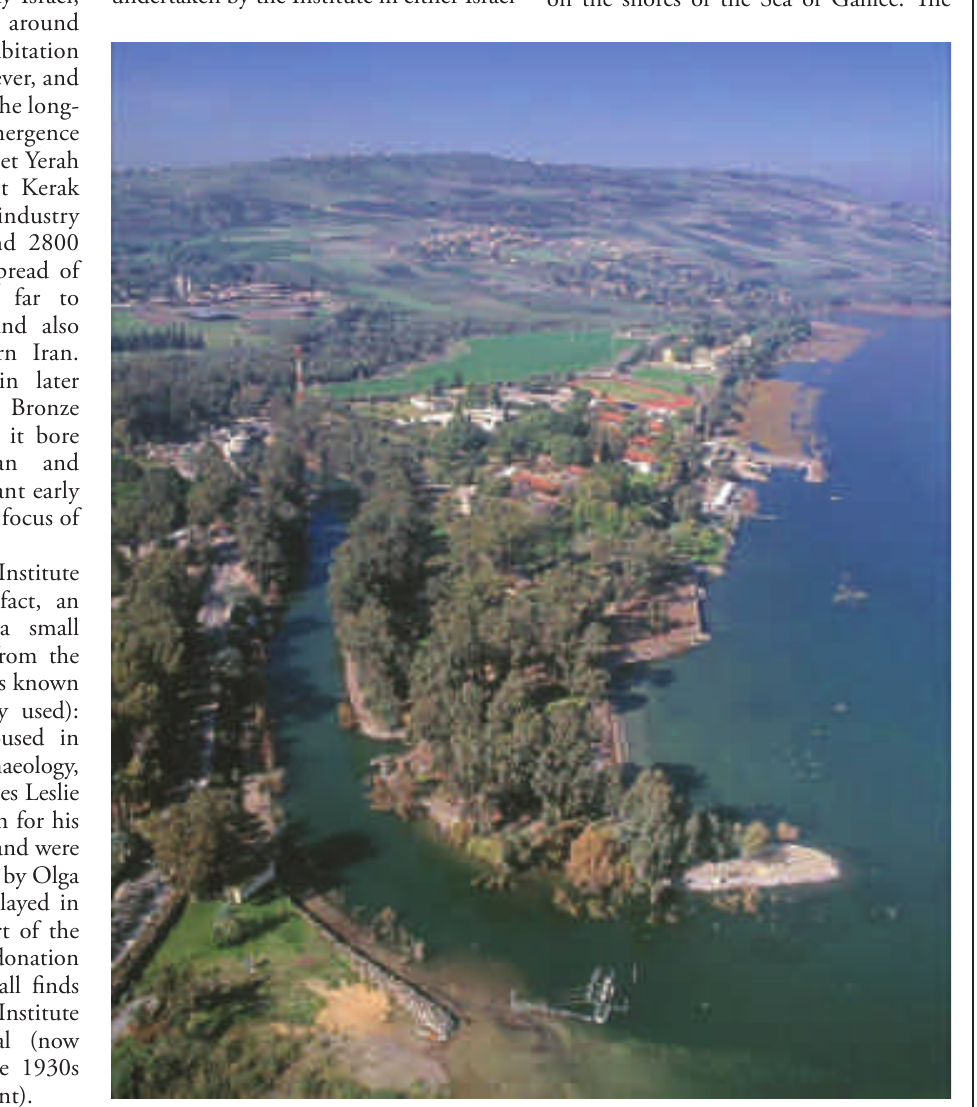
Figure 8 The 2009 team, on the final day of excavations